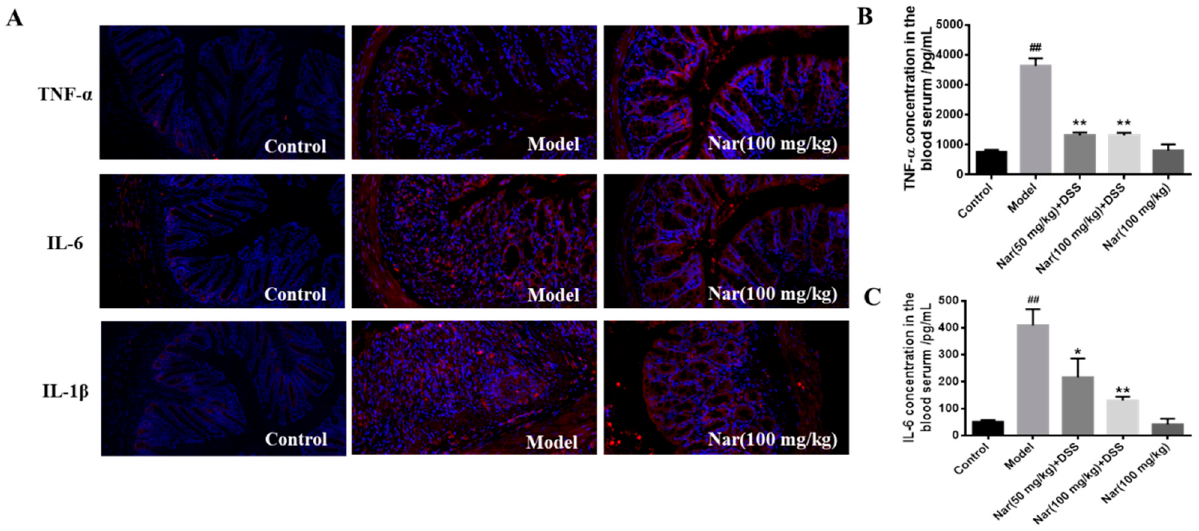
Figure 3. Effect of naringin on the expression of inflammatory cytokines in ulcerative colitis mice. ( A ) TNF- α , IL-6 and IL-1 β distribution in the colons of each group (immunofluorescence analysis, 200 × ). ( B ) Concentration of TNF- α in the blood serum. ( C ) Concentration of IL-6 in the blood serum. Data are presented as means ± SD ( n = 3). ## p < 0.01, compared with the control group; * p < 0.05 and ** p < 0.01, compared with the model group.